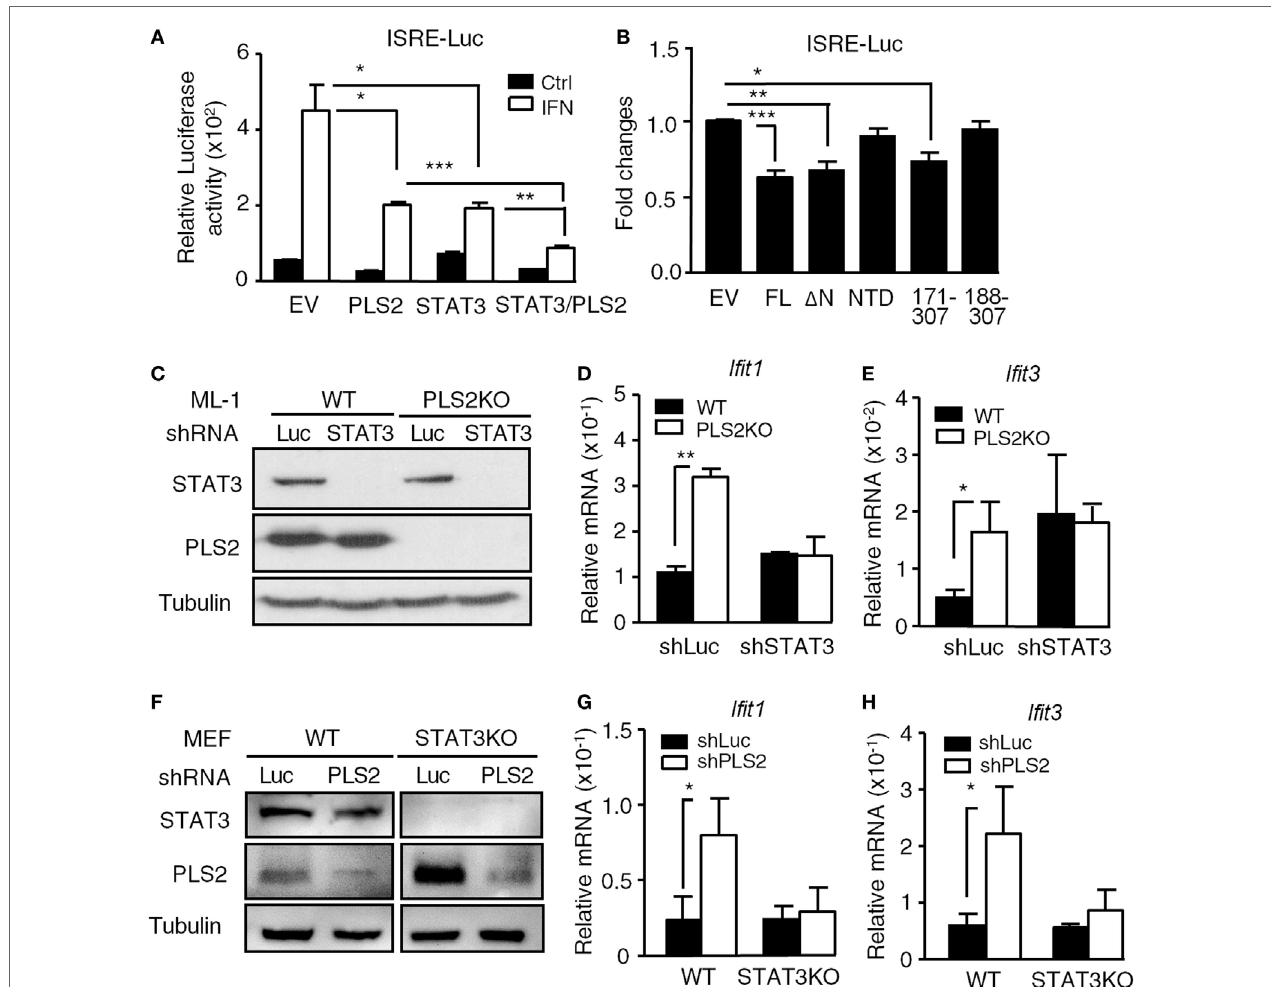
FigUre 4 | The suppressive effects of phospholipid scramblase 2 (PLSCR2) are STAT3 dependent. (a) ISRE-luc reporter plasmid was cotransfected with empty vector (EV) or vector expressing myc-PLSCR2 (PLS2) and/or HA-STAT3 and pEGFP-N1 in HEK293T cells for 24 h, followed by treatment with human IFN- α 2 for 8 h. Total cell lysates were subjected to luciferase activity assay. Relative luciferase activity was normalized to the GFP + percentage ( N = 3). (B) Same as in panel (a) , except ISRE-luc was cotransfected with full length (FL) or different truncated mutants of PLSCR2 and pEGFP-N1 in HEK293T cells. Fold changes were normalized to EV control ( N = 7). (c) WT and PLS2KO ML-1 cells were stably transduced with lentivirus expressing shLuc or shSTAT3. Total cell lysates were subjected to immunoblotting with antibodies against STAT3, PLSCR2, and tubulin. Blots are representative of two independent experiments. (D,e) WT or PLS2KO ML-1 cells stably transduced with shLuc or shSTAT3 were stimulated with mouse IFN- α 4 for 6 h. Total RNA was subjected to RT-QPCR using primers to Ifit1 (D) , Ifit3 (e) , and Rpl7 . Relative mRNA was normalized to Rpl7 ( N = 3) . (F) WT and STAT3KO mouse embryonic fibroblasts (MEFs) were stably transduced with lentivirus expressing shLuc or shPLS2. Total cell lysates were subjected to immunoblotting as in panel (c) . (g,h) Same as in panels (D,e) , except WT or STAT3KO MEFs stably transduced with shLuc or shPLS2 were used ( N = 3). Data are shown as mean ± SD, * p < 0.05, ** p < 0.01, and *** p <